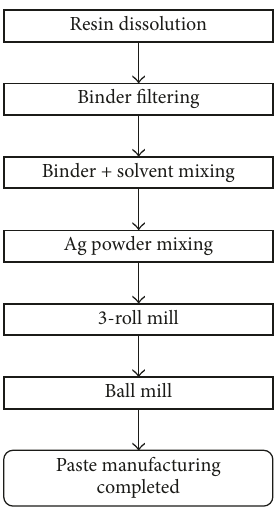
Figure 1: Preparation process of Ag paste.